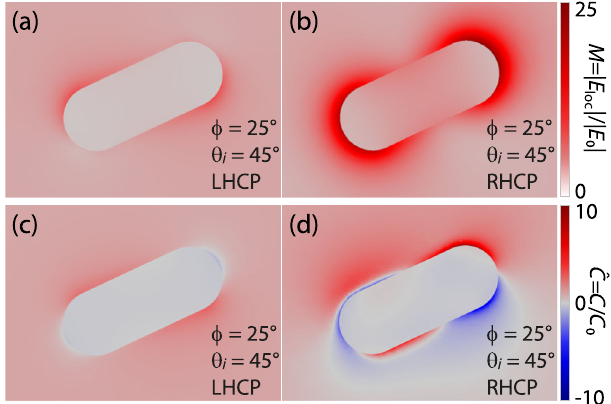
FIG. 5. Near-field properties at the main plasmon resonance j = j E j wavelength. Calculated near-field enhancement M ¼ j E 0 loc under (a) LHCP and (b) RHCP illumination and the optical ˆ C ¼ C=C chirality enhancement 0 under (c) LHCP and (d) RHCP illumination. All figures represent the case of θ i ¼ 45 ° and FIG. 6. Polarization properties of the reflected light. (a) Exper- ϕ ¼ 25 °, and all data are from a plane 10 nm above the glass- imental and (b) calculated circular polarization components of the air interface. C 0 is the optical activity without any nanoparticle. reflected light at θ i ¼ 45 ° and ϕ ¼ 25